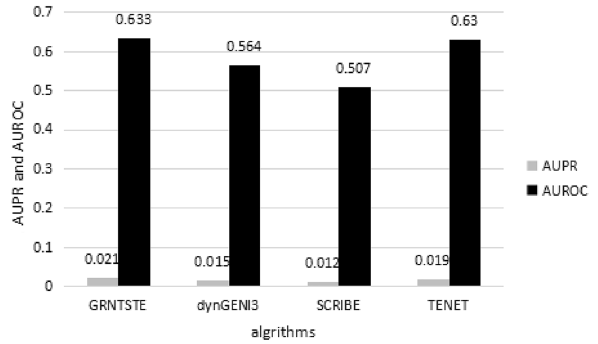
Figure 2. The average value of AUPRC and AUROC obtained for GRNTSTE, dynGENIE3, SCRIBE and TENET algorithms on the datasets with 50 genes.